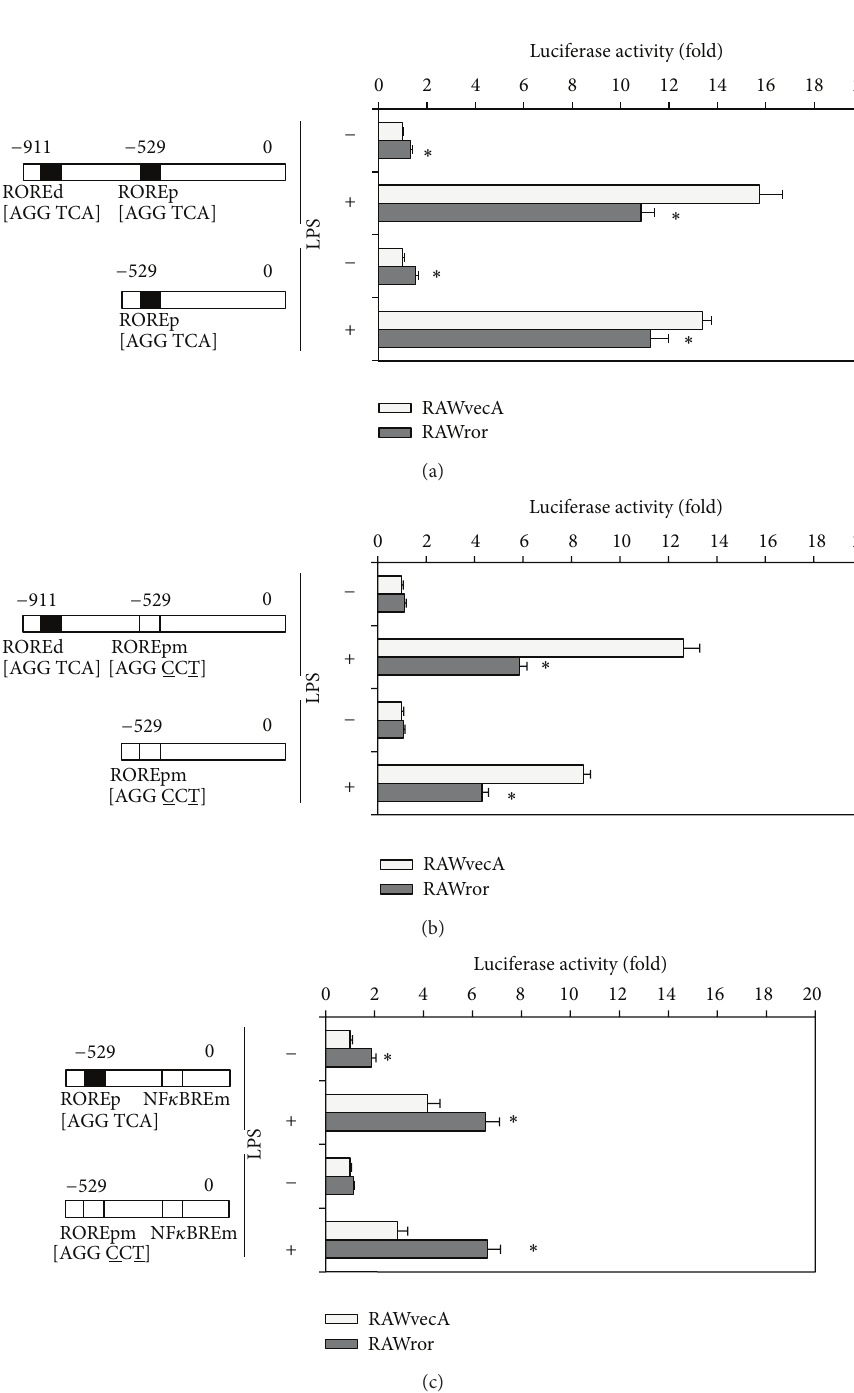
Figure 4: Effect of ROR 𝛼 on il6 promoter activity. (a) RAWror and RAWvecA cells were transiently transfected with luciferase reporter construct containing either a distal or a proximal construct of il6 promoter. After treatment with or without 1 𝜇 g/mL LPS for 24 h, luciferase activities were determined. ROREd, distal RORE; ROREp, proximal RORE. (b) The AGGTCA half-site in the proximal RORE was changed to AGGCCT by site-directed mutagenesis of nucleotides − 518 (A to T) and − 520 (T to C), and luciferase activities of each cell either untreated or treated with LPS for 24 h were determined. ROREpm, proximal RORE mutant. (c) The GGGATTTTCC half-site in the NF 𝜅 BRE was changed to GGGCCCTTCC by site-directed mutagenesis of nucleotides − 86 (T to C), − 87 (T to C), and − 88 (A to C), and luciferase activities of each cell either untreated or treated with LPS for 24 h were determined. NF 𝜅 BREm, NF 𝜅 BRE mutant. Luciferase values were normalized using Renilla luciferase. The data are presented as the means ± S.E. from sextuplicate cultures. ∗ 𝑃 < 0.05 versus vector